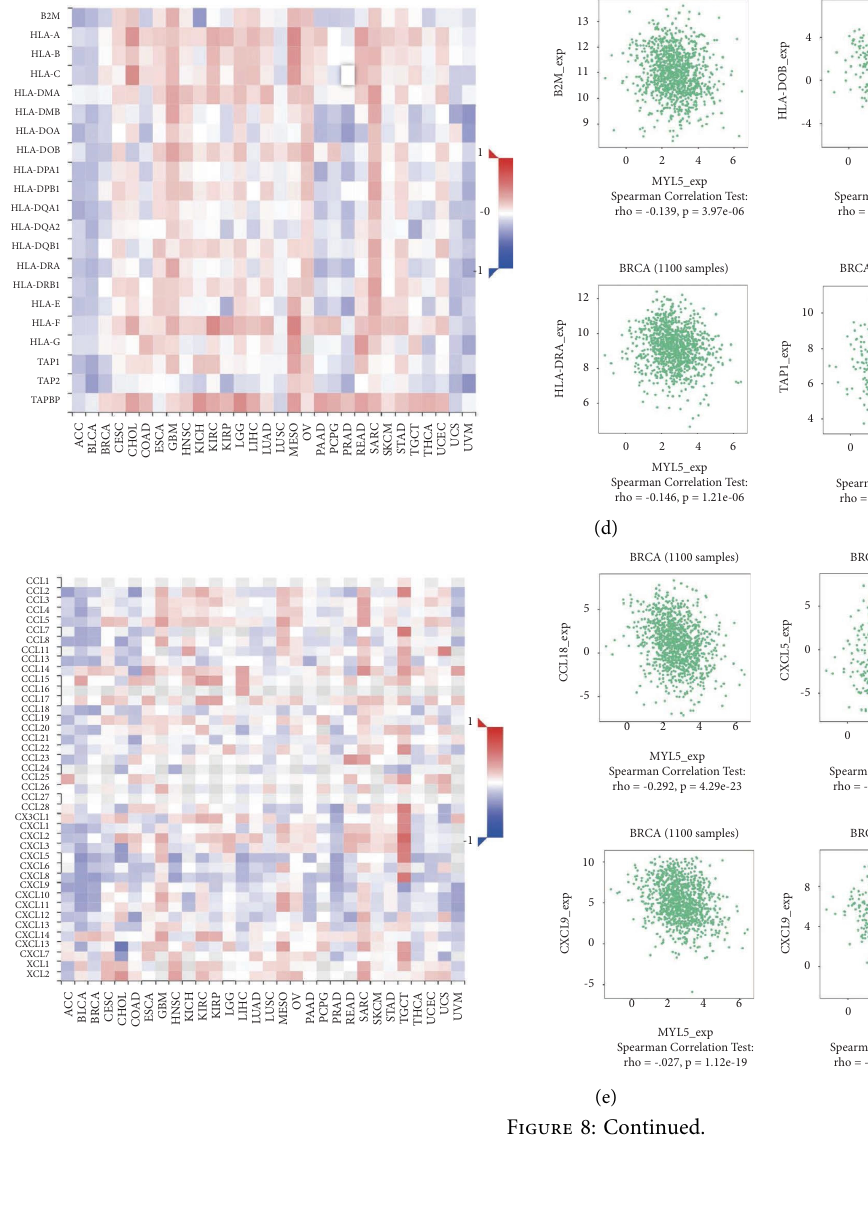
Spearman Correlation Test: rho = -0.284, p = 7.36e-22